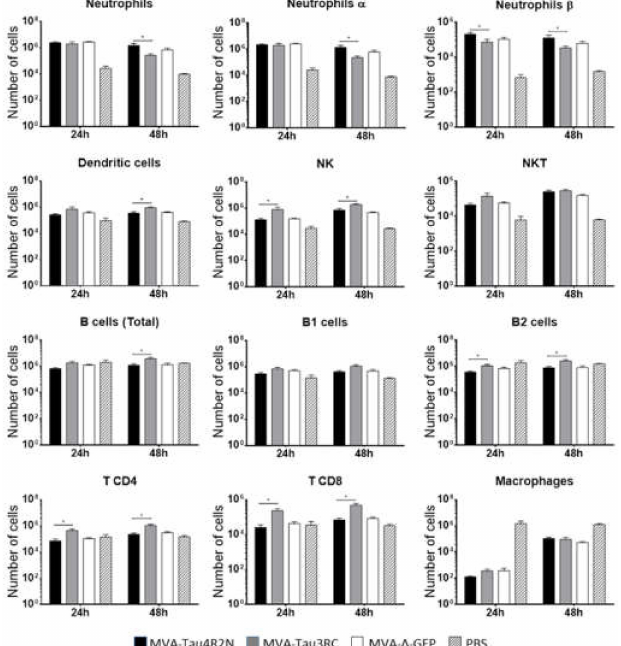
Figure 4. Recruitment of innate immune cells in the peritoneal cavity of mice infected with MVA-Tau4R2N and MVA-Tau3RC. Absolute numbers of innate immune cell populations obtained from the peritoneal cavity of C57BL / 6 mice infected by the i.p. route with MVA-Tau4R2N, MVA-Tau3RC, MVA- ∆ -GFP, or PBS. Peritoneal exudate cells were collected at 24 and 48 h post inoculation from each individual mouse ( n = 5 per group), stained for di ff erent surface markers and absolute numbers were analyzed by flow cytometry. Graphs show the logarithmic mean ± SD, and statistical significance di ff erence between MVA-Tau4R2N and MVA-Tau3RC groups are included (* p ≤